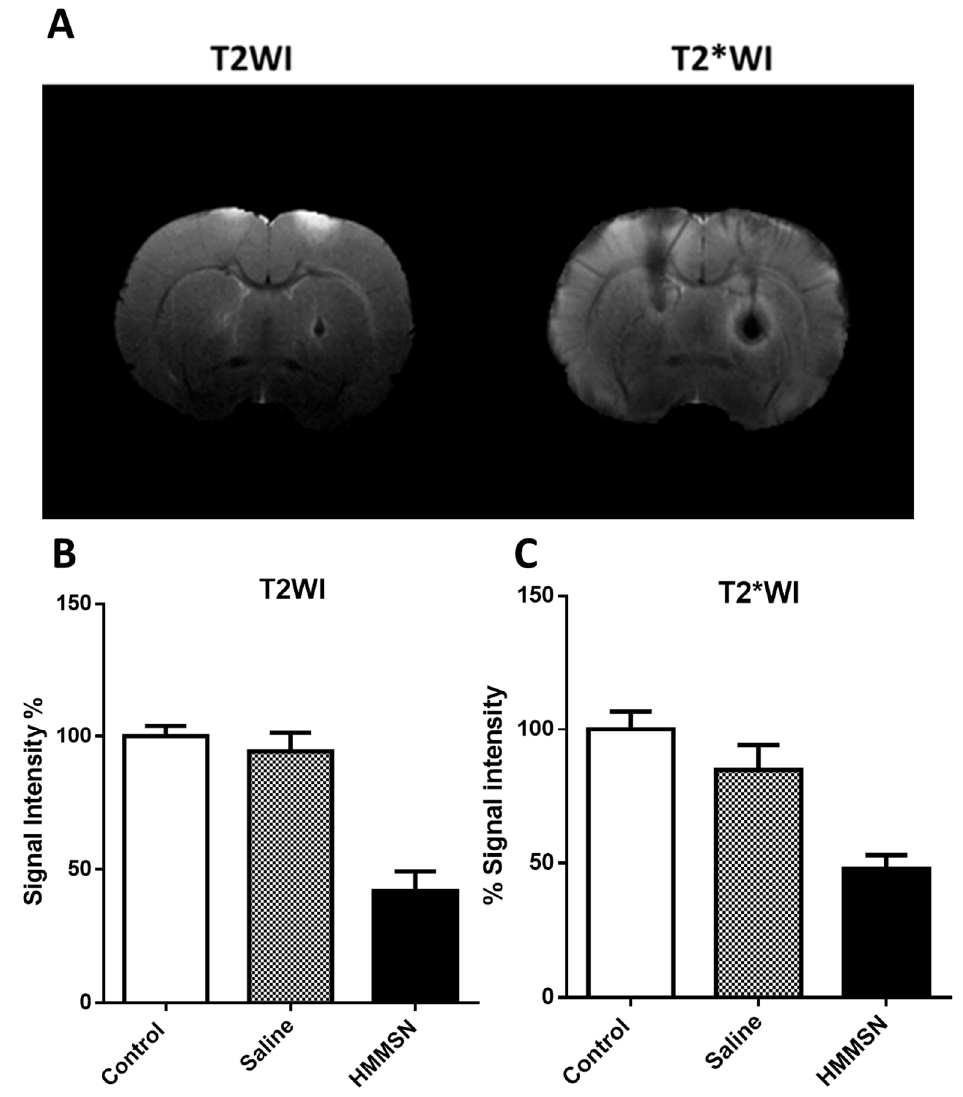
Figure 11. ( A ) T2 and T2* weight images after intraparenchymal injection of 10 µ L 0.9% NaCl saline (left hemisphere) and 10 µ L of a suspension (0.41 mg/mL) of HMMSN hybrid magnetic mesoporous nanorods in saline (right hemisphere). ( B , C ) % signal intensity is decreased in the injection area compared to the control for normal tissue intensity in T2 and T2* weight images, respectively. (N = 2/group).